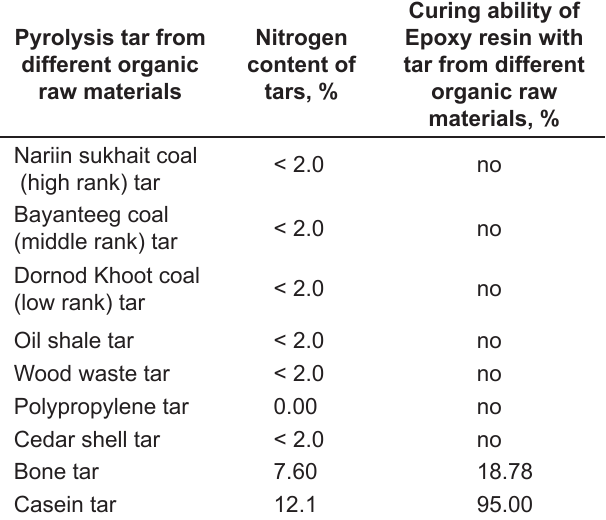
Table 7. The results of testing pyrolysis tar from different organic raw materials as a curing agent for epoxy